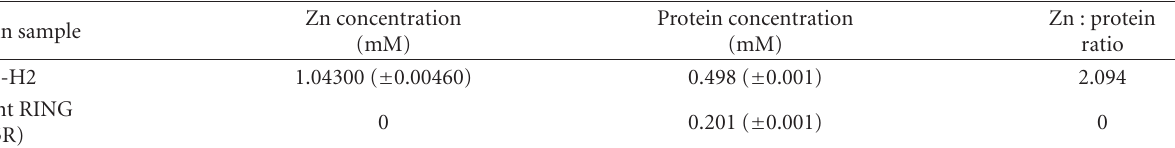
Table 2: Cumulative results of zinc: protein ratio for the samples analyzed.